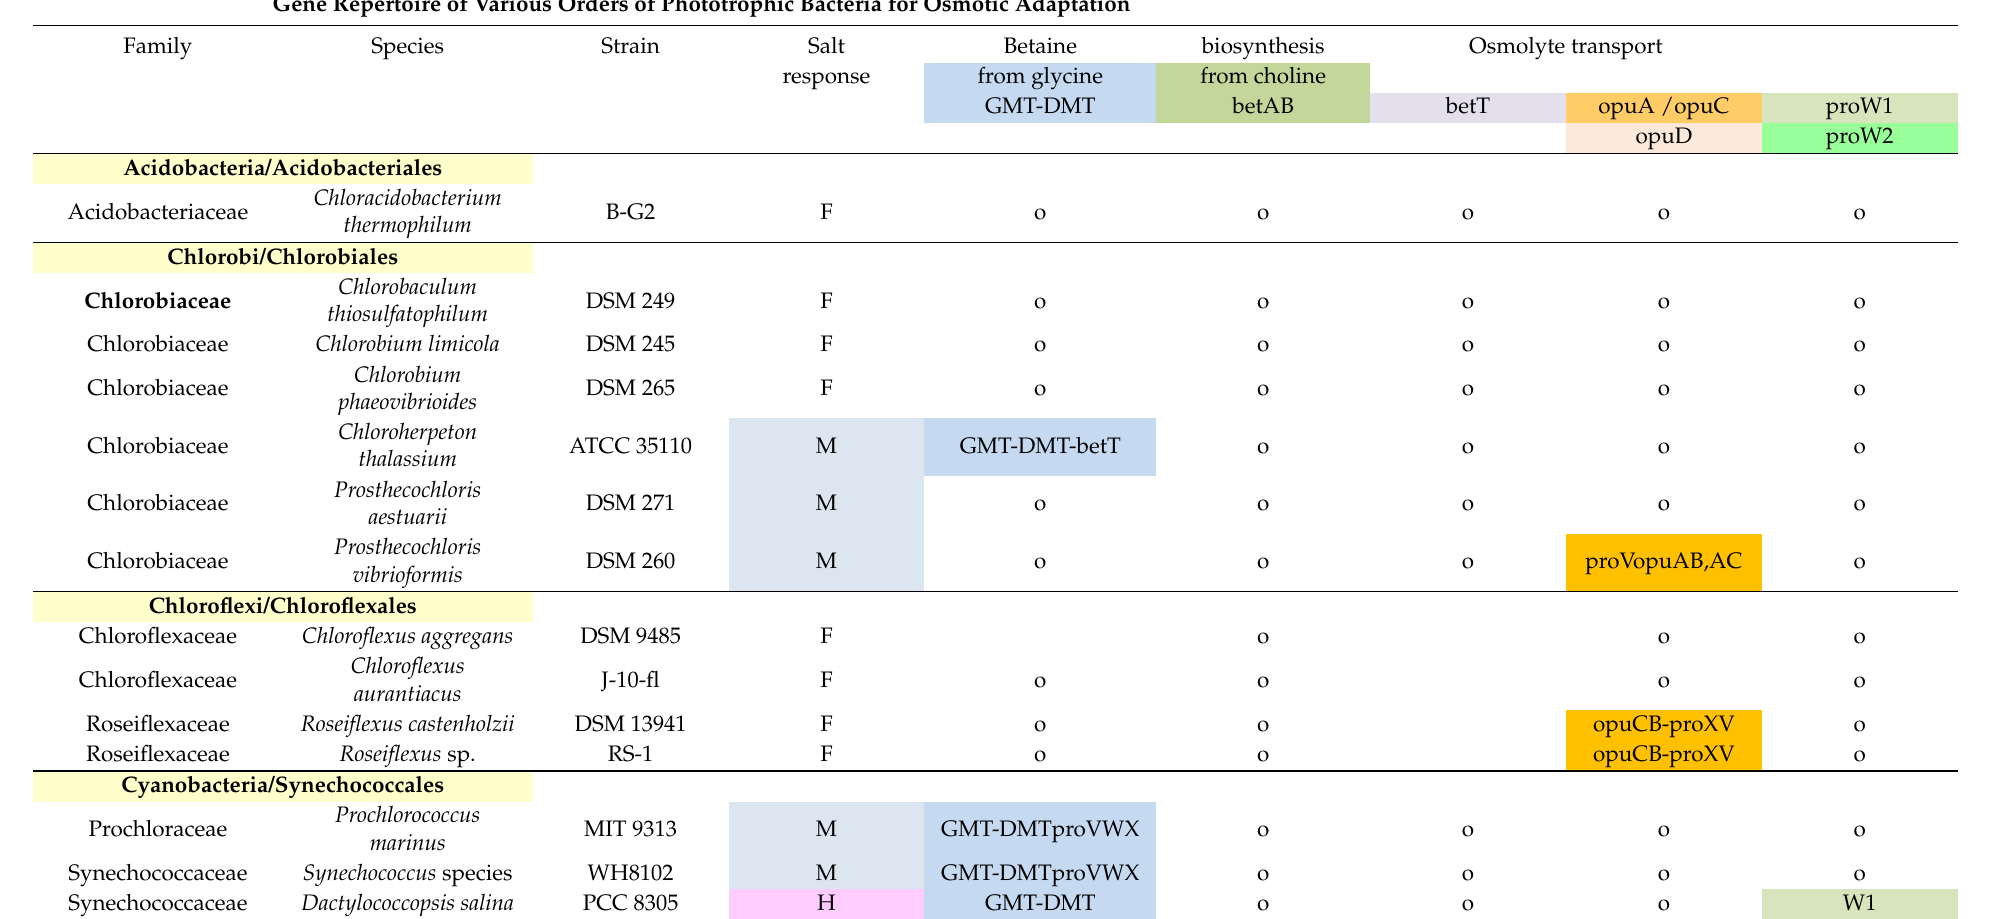
Table 1. Genes and gene clusters of betaine and ectoine biosynthesis as well as relevant transport systems of phototrophic Acidobacteria ( Chloracidobacterium ), Chlorobi , Chloroflexi , Cyanobacteria , Heliobacterium modesticaldum , Gemmatimonas phototrophica and Betaproteobacteria are shown together with salt responses and their systematic affiliation a,b,c . Gene Repertoire of Various Orders of Phototrophic Bacteria for Osmotic